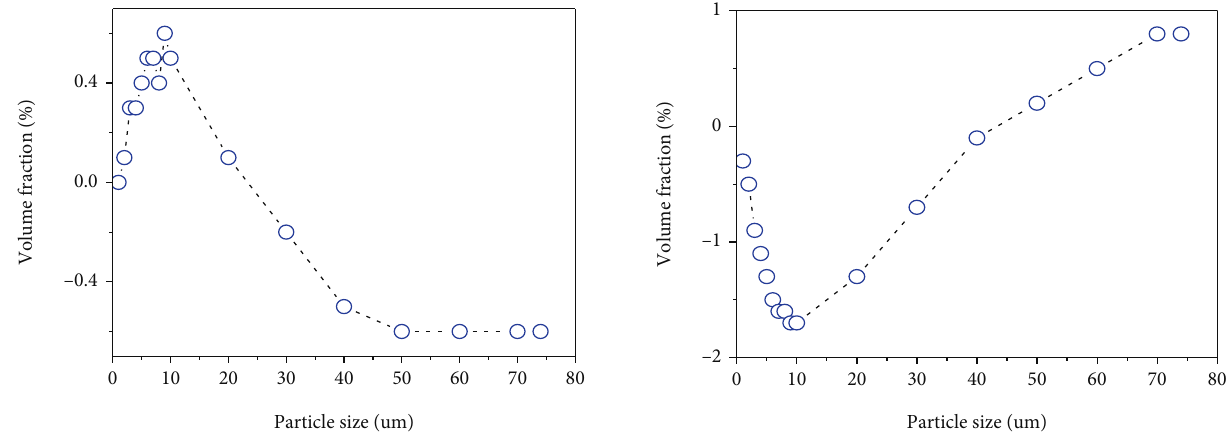
Figure 10: E ff ect of di ff erent head di ff erences on the transport of